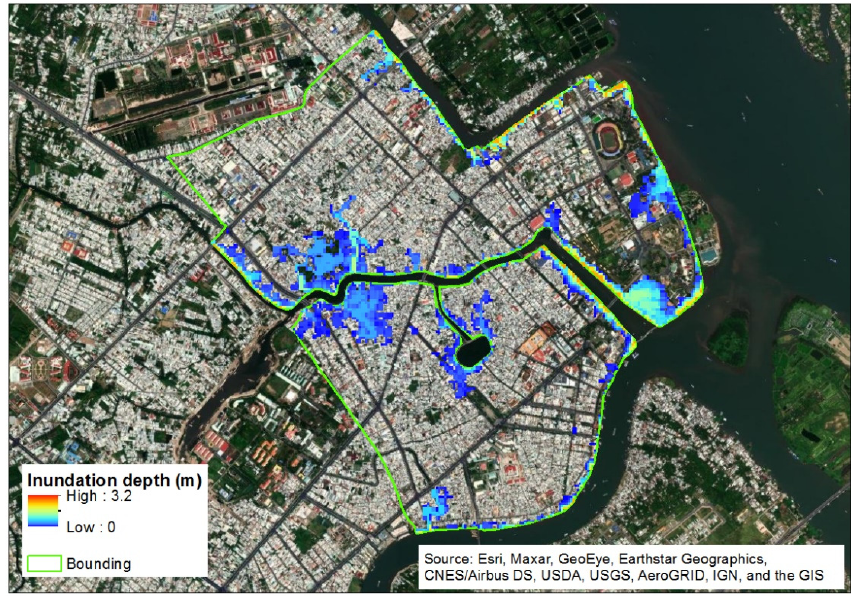
Figure 3. Inundation map corresponding to 100-year return period water level at Can Tho in the year